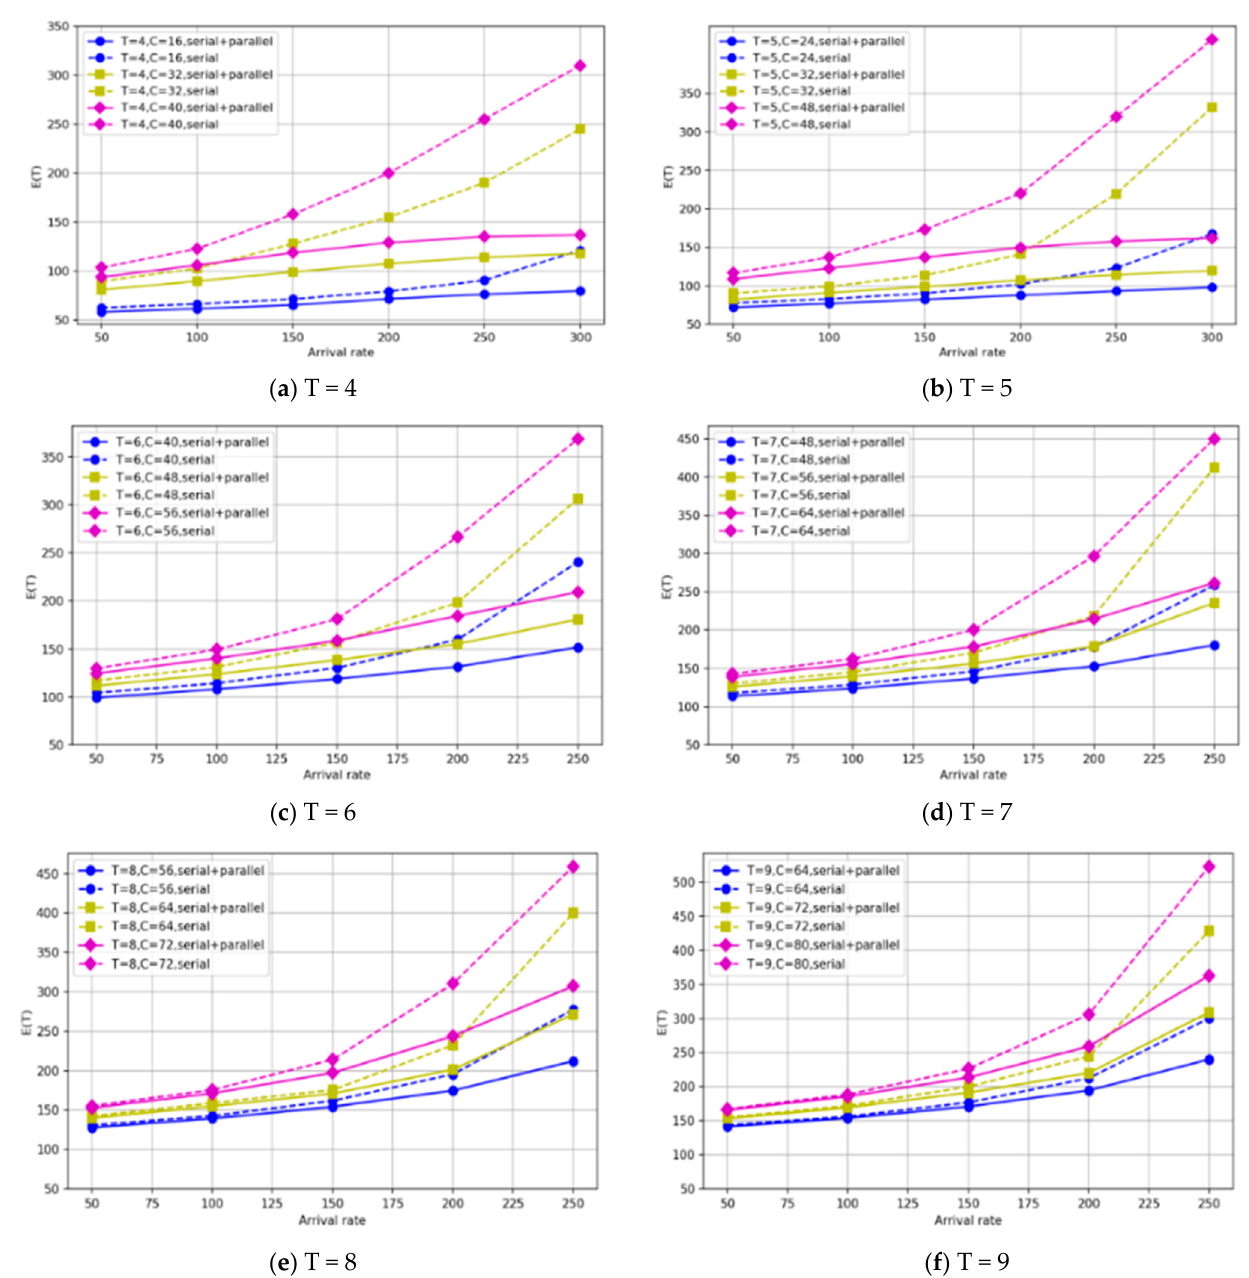
Figure 14. Comparison of operational policies with different system size configurations. (( a ): The E(T) curves in the case of T = 4,C at 56, 64, and 72, respectively, for the shuttle operation strategy with a combination of serial and parallel, respectively, and the serial case alone. ( b ): The E(T) curves in the case of T = 5, C at 24, 32, and 48, respectively, for the shuttle operation strategy with a combination of serial and parallel, respectively, and the serial case alone. ( c ): The E(T) curves in the case of T = 6, C at 40, 48, and 56, respectively, for the shuttle operation strategy with a combination of serial and parallel, respectively, and the serial case alone. ( d ): The E(T) curves in the case of T = 7, C at 48, 56, and 64, respectively, for the shuttle operation strategy with a combination of serial and parallel, respectively, and the serial case alone. ( e ): The E(T) curves in the case of T = 8, C at 56, 64, and 72, respectively, for the shuttle operation strategy with a combination of serial and parallel, respectively, and the serial case alone. ( f ): The E(T) curves in the case of T = 9, C at 64, 72, and 80, respectively, for the shuttle operation strategy with a combination of serial and parallel, respectively, and the serial case